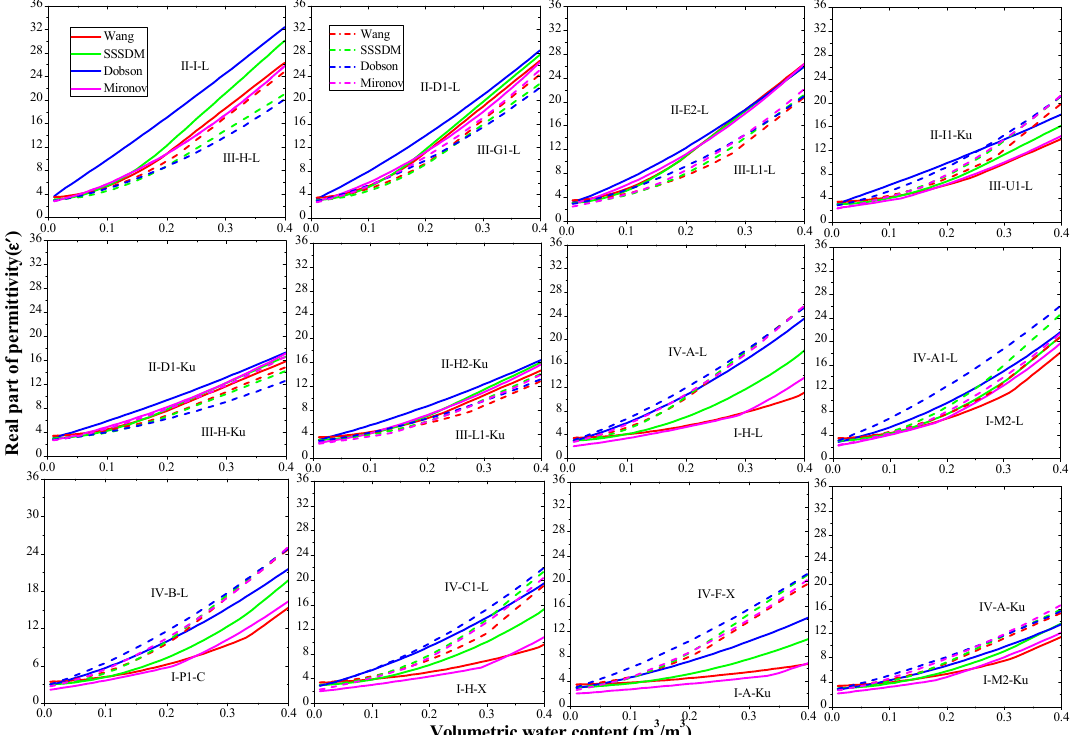
Figure 3. Simulated real parts of typical soil samples for di ff erent models. A solid line is used for soil texture cases in Section I or II; and a dashed line is used for soil texture cases in Section III or IV. “II-I-L” stands for I sample from Section II at the